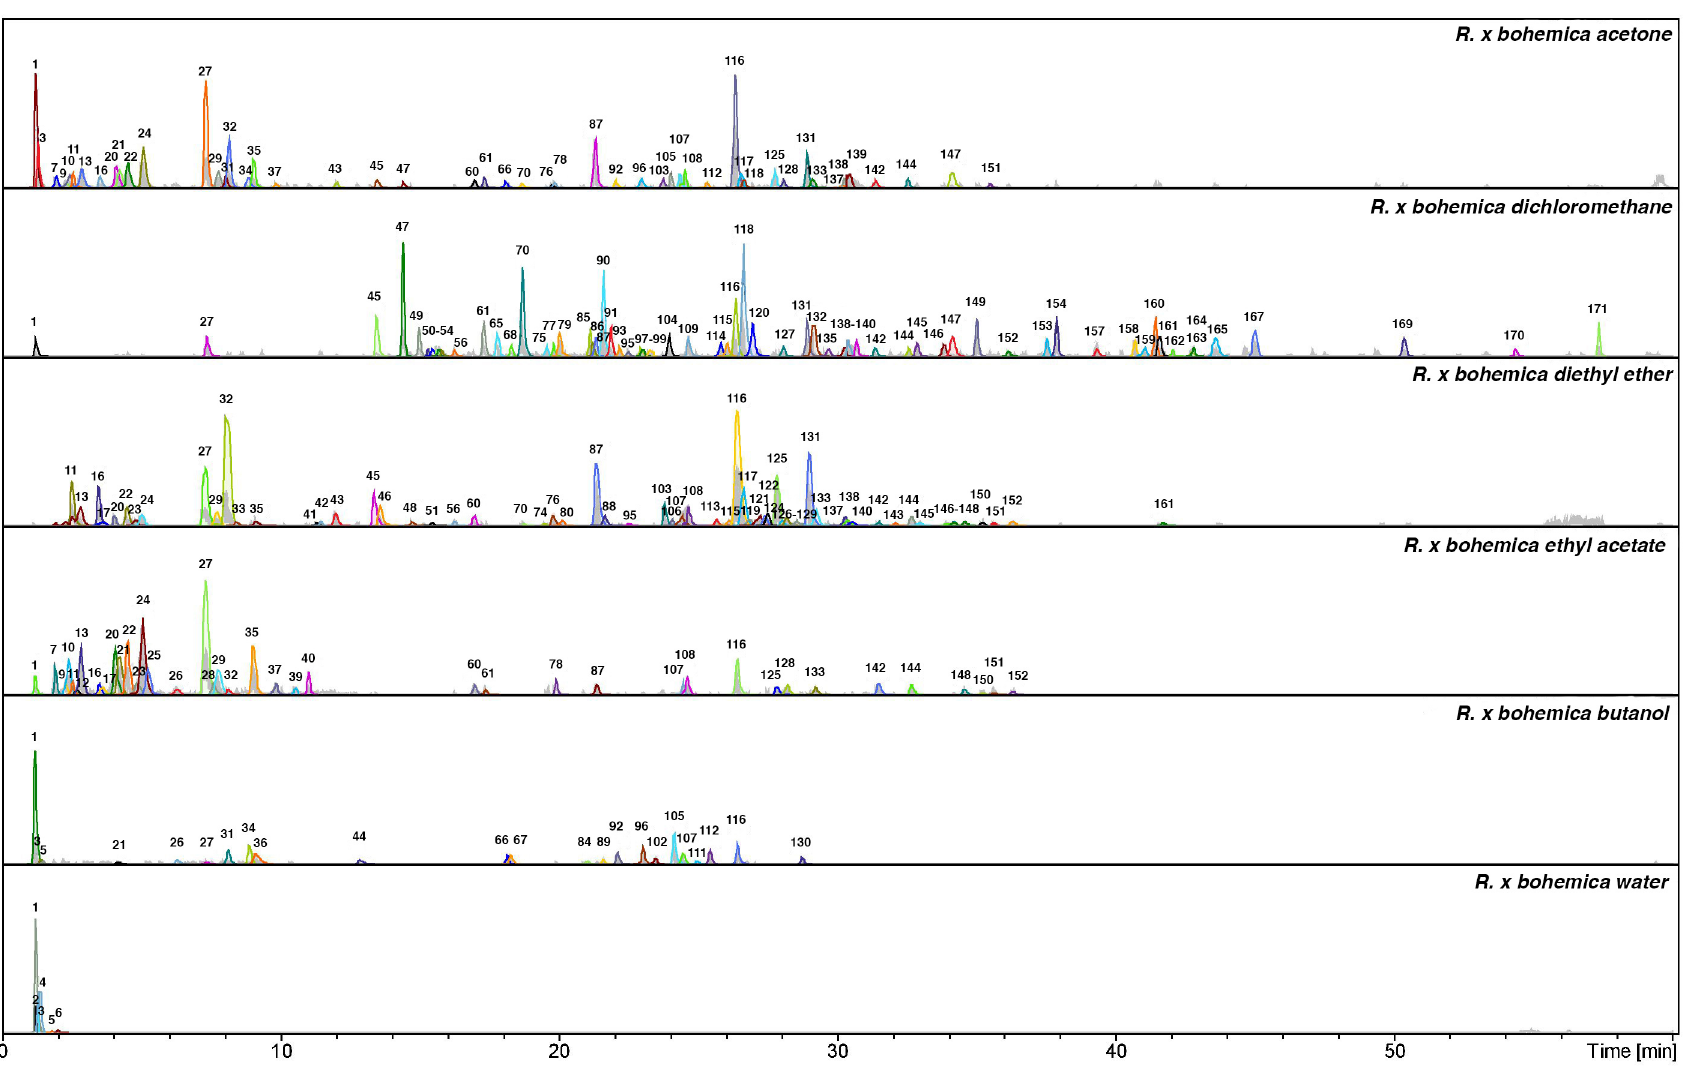
Figure 2. Total ion chromatograms in negative ionization mode and dissect chromatograms of Reynoutria x bohemica extract and fractions. Deconvolution of an LC/MS mass chromatogram was carried out by using the Bruker’s Dissect algorithm. Peak numbers are explained in Table